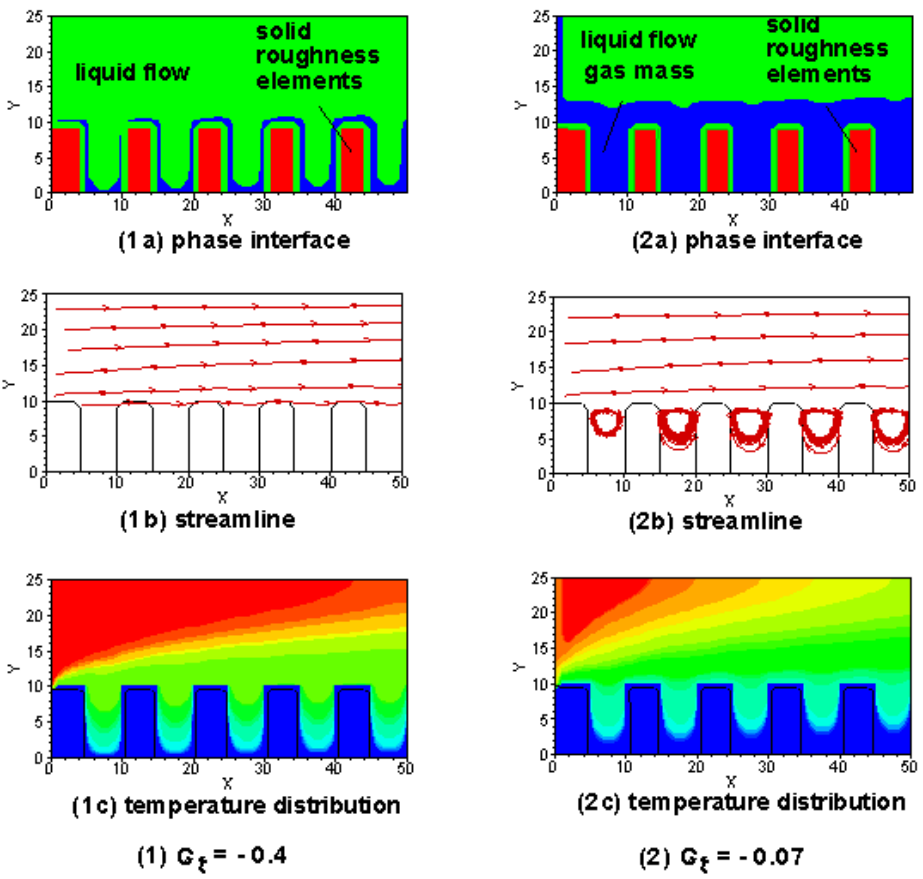
Figure 13. ( a ) Phase interface; ( b ) streamline and ( c ) temperature distribution for the